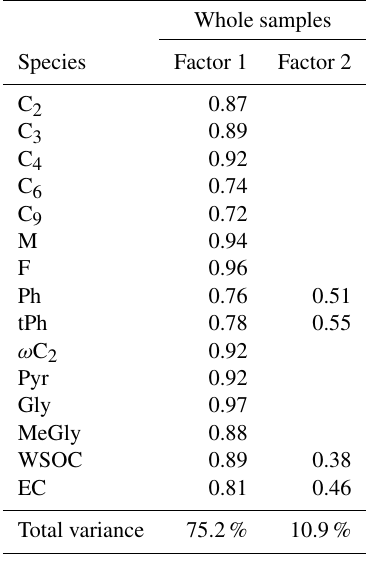
Table 4. Results of the principal component analyses for selected diacids and related compounds in PM 2 . 5 in